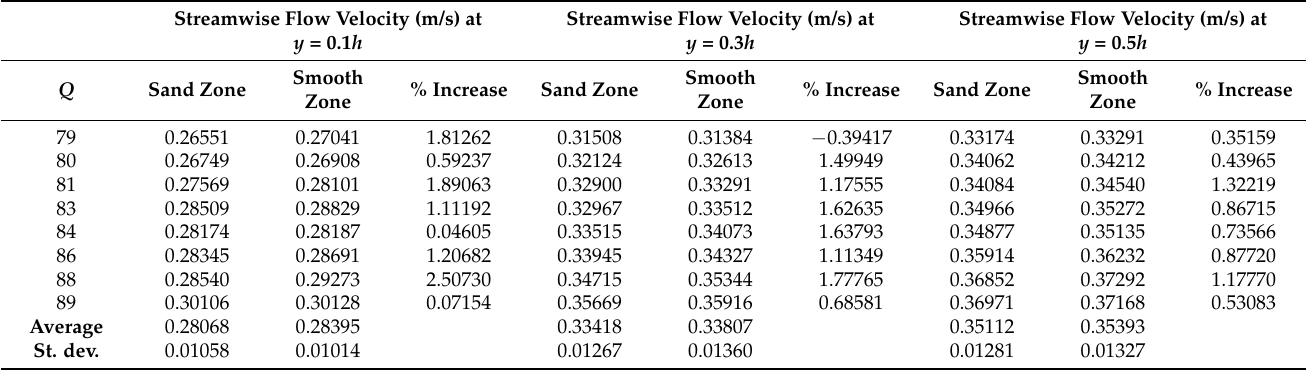
Figure 2. Velocity variations at different depths, y = 0.1 h , y = 0.3 h and y = 0.5 h. Since it is a closed conduit and because of symmetricity, the streamwise flow velocity is considered only from bottom to center of the conduit. It shows that the streamwise velocity decreases in the sand zone at different depths although the flow rate in the closed conduit is the same. Although the flow velocity difference is small between the sand zone and smooth zone, such small difference can cause significant change of turbulent quantities. It is apparent that the profiles shift more sharply at y = 0.3 h and y = 0.5 h than at y = 0.1 h . The computed velocity variations are tabulated in Table 2 for both zones. Table 2. Streamwise flow velocity variations at specified